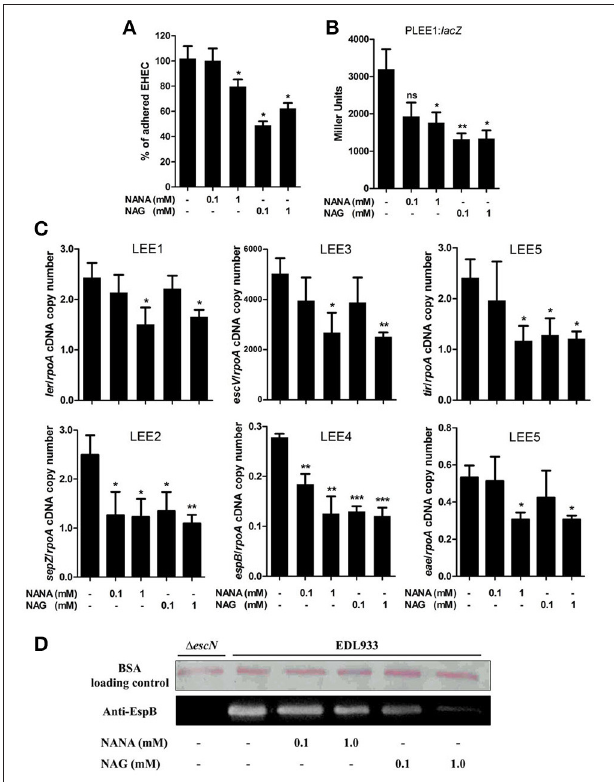
FIGURE 1 | NANA and NAG regulate EDL933 adhesion and LEE expression. (A) HeLa cells were co-incubated with EDL933 in DMEM with or without NANA or NAG for 90min. Bacteria adhered to HeLa cells were harvested and counted on agar plates. Results are presented as the percentage of adhesion as compared to the wild type strain incubated without NANA or NAG. (B) β -galactosidase assays using the P LEE1 : lacZ transcriptional fusion integrated into EDL933. EDL933 was grown in DMEM with or without NANA or NAG 0.1 or 1 mM and cells were harvested at OD 600 = 0.6. Results are presented as Miller Units. (C) qRT-PCR measurement of LEE gene expression in DMEM with or without NANA or NAG. Results are shown as the ratio copy number of the LEE transcripts/copy number of rpoA transcripts. (D) Western blot analysis of the EspB secretion by EDL933 grown in DMEM with or without NANA or NAG. BSA was used as a loading control. n ≥ 3, ns for non-significant, * p < 0.05, ** p < 0.01, and *** p <